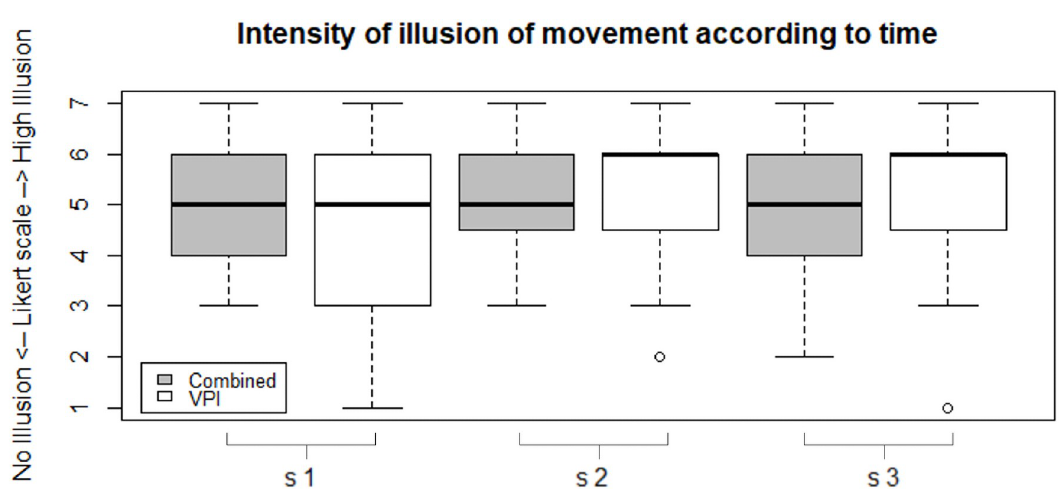
Fig 7. Intensity of illusion of movement according to time. Boxplot representations of the intensity of illusion of movement in combined condition (grey boxplot) and in VPI condition (white boxplot) according to time (session 1 (s1) to 3 (s3)).